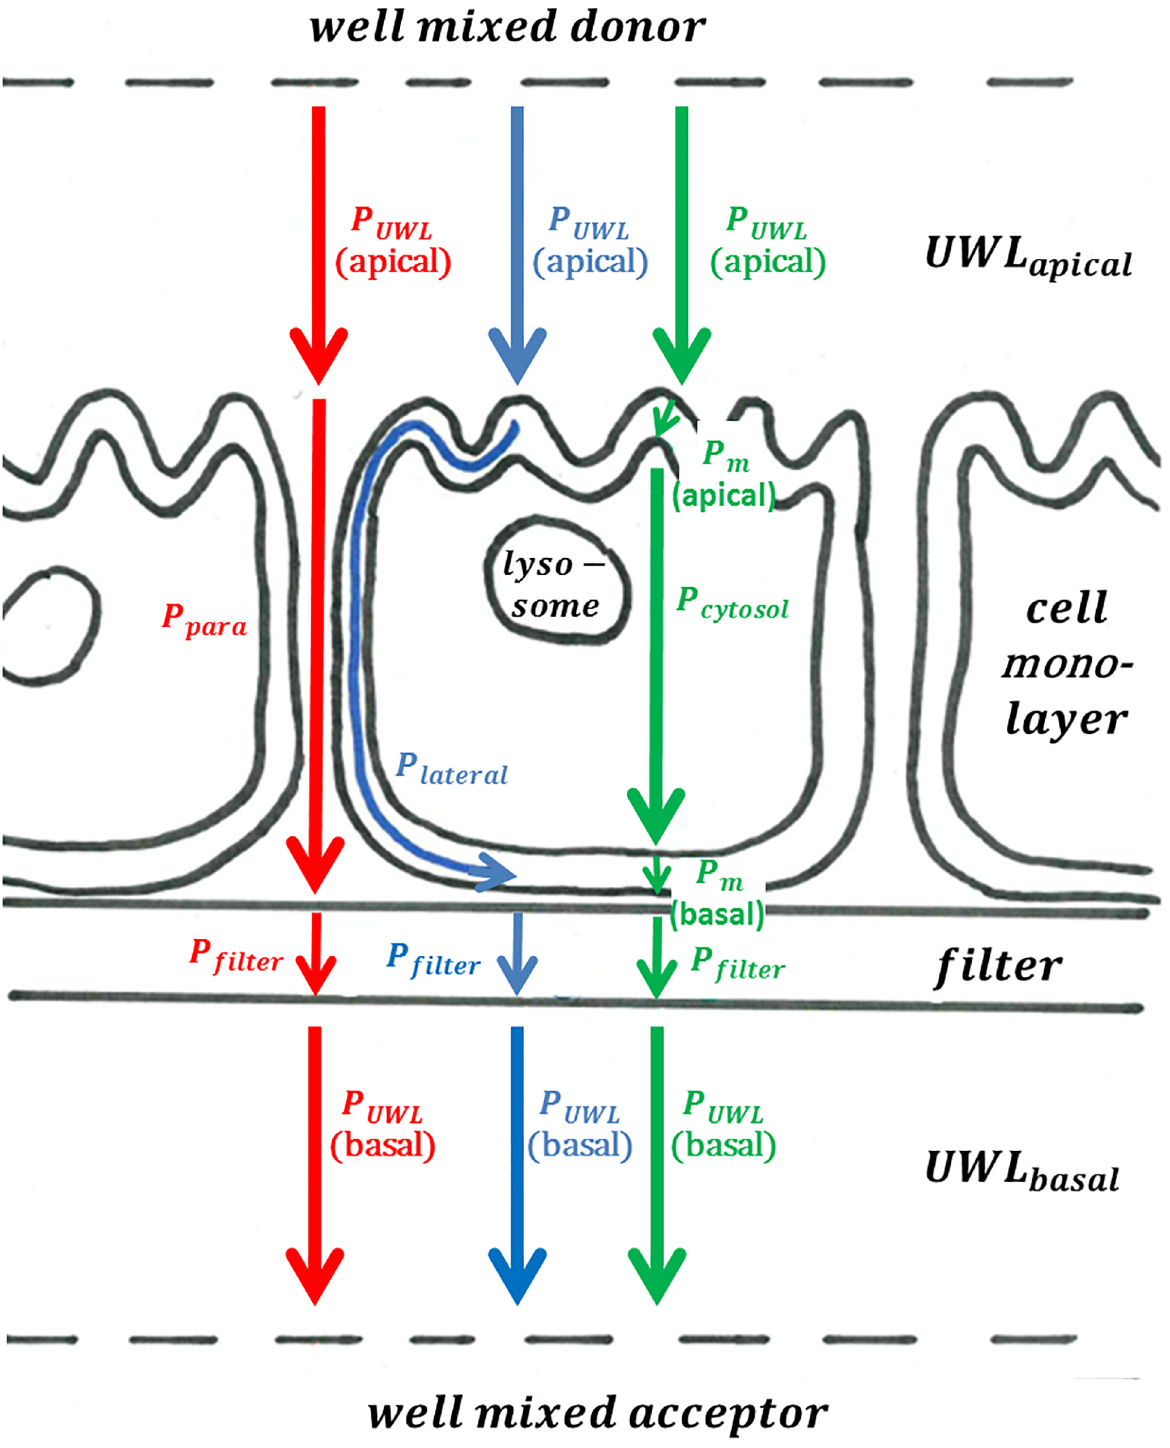
Fig 1. Mechanistic overview showing the three modeled parallel permeability pathways in three different colors (red, blue and green) as well as the serial particular permeabilities they comprise. The paracellularpermeationpathway, P total is comprisedof P UWL (apical), P para , P filter and P UWL (basal); the lateral permeationpathway, P total P UWL (apical), P lateral , P filter and P UWL (basal);, and finally the cytosolic permeation pathway, P total P UWL (apical), P m , P cytosol , P m , P filter and P UWL (basal).